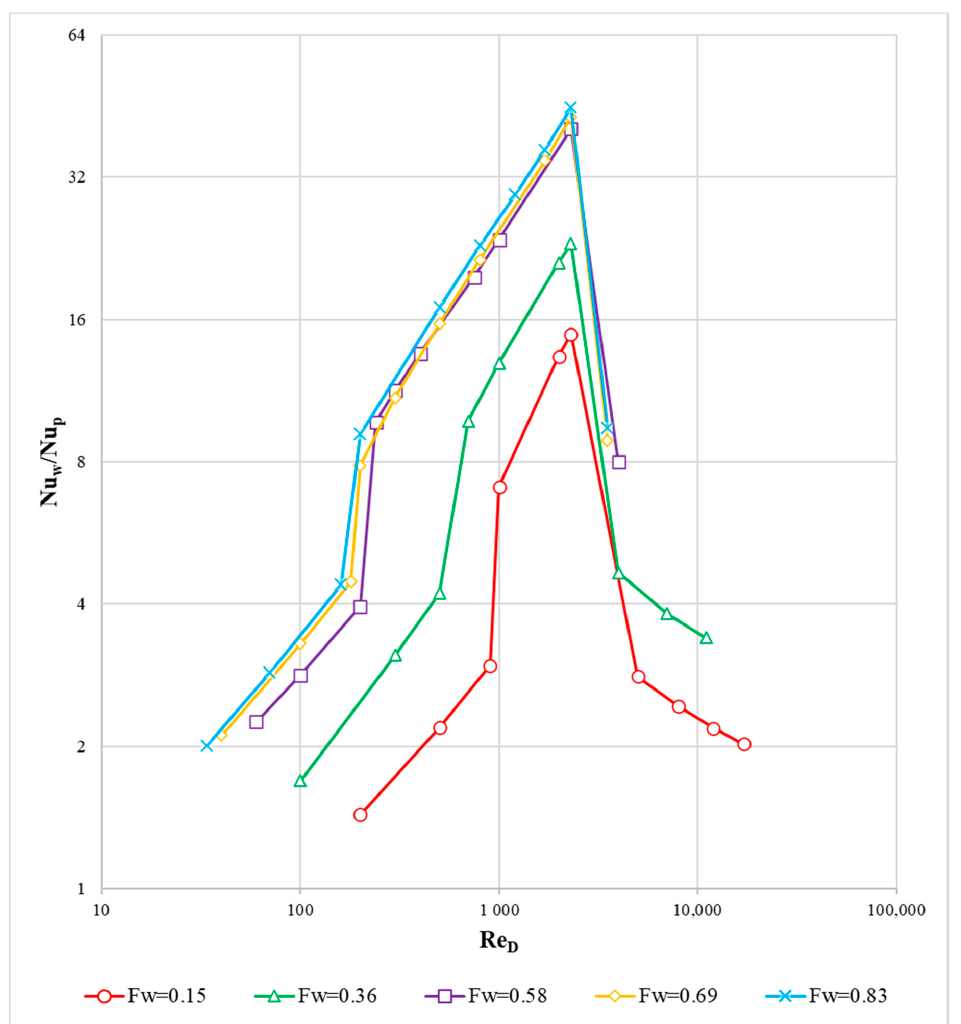
Figure 13. Heat transfer enhancement in wavy-walled tubes.